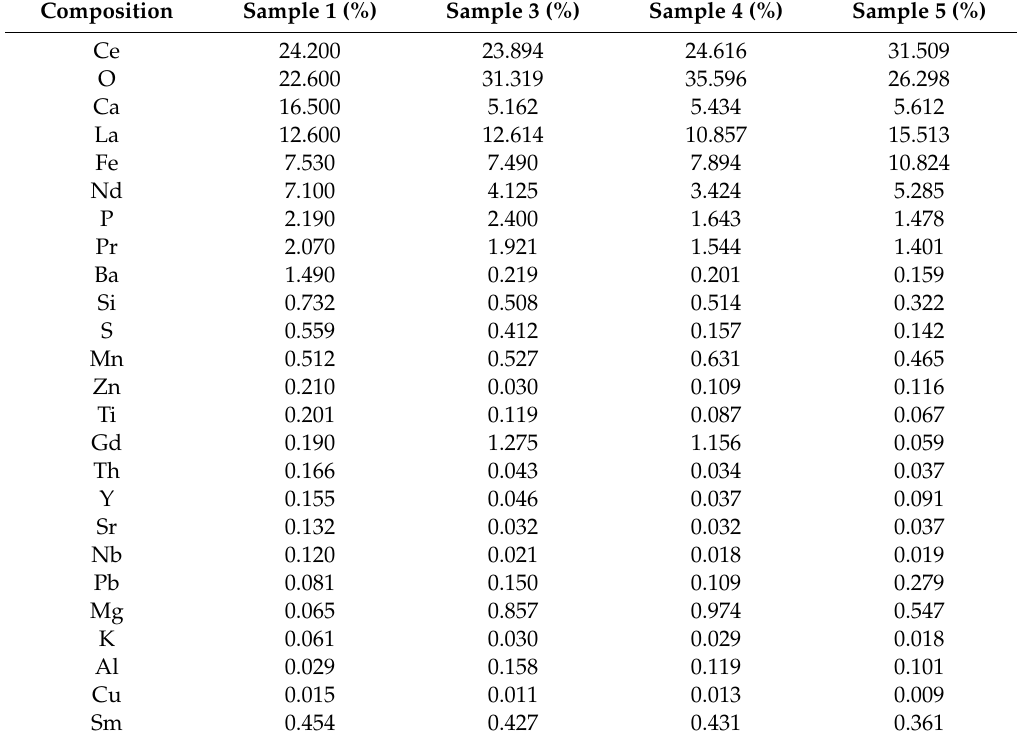
Table 1. Elemental analysis of rare earth concentrates (unit: assemblage